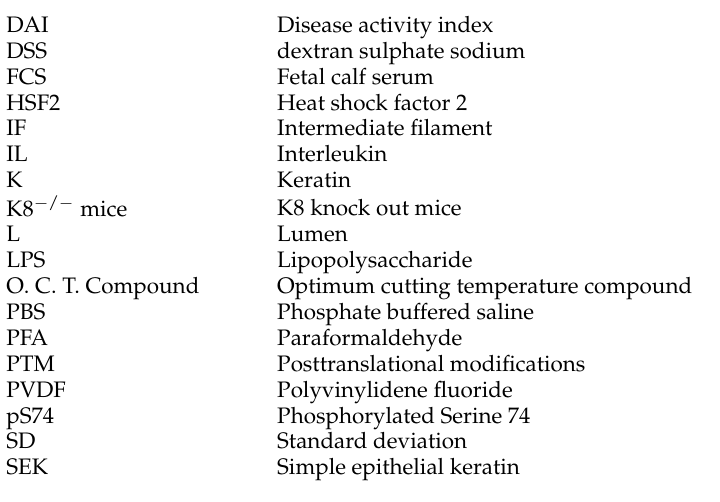
Figure S1: K18 and K19 distribution is not altered in response to chronic DSS-treatment, Figure S2: A slight increase in K8 pS74 was seen in proliferating cells compared to non-proliferative cells following antibiotic treatment, Figure S3: The distribution of K18 and K20 is unaltered in response to antibiotic-treatment, Figure S4: The amount and distribution of K20 in LPS-treated HT-29 cells is